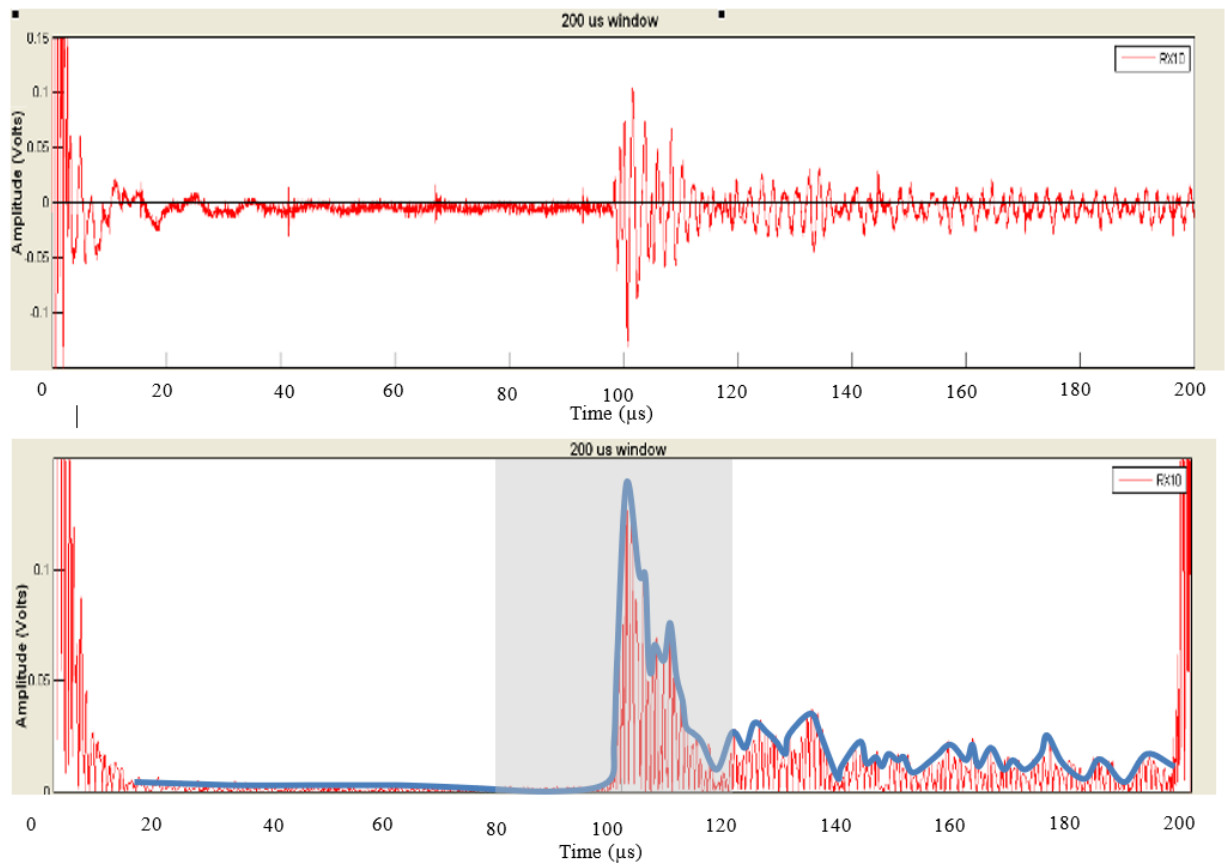
Figure 8. An illustration of the raw signal ( top ) vs. the post-processed result ( bottom ).